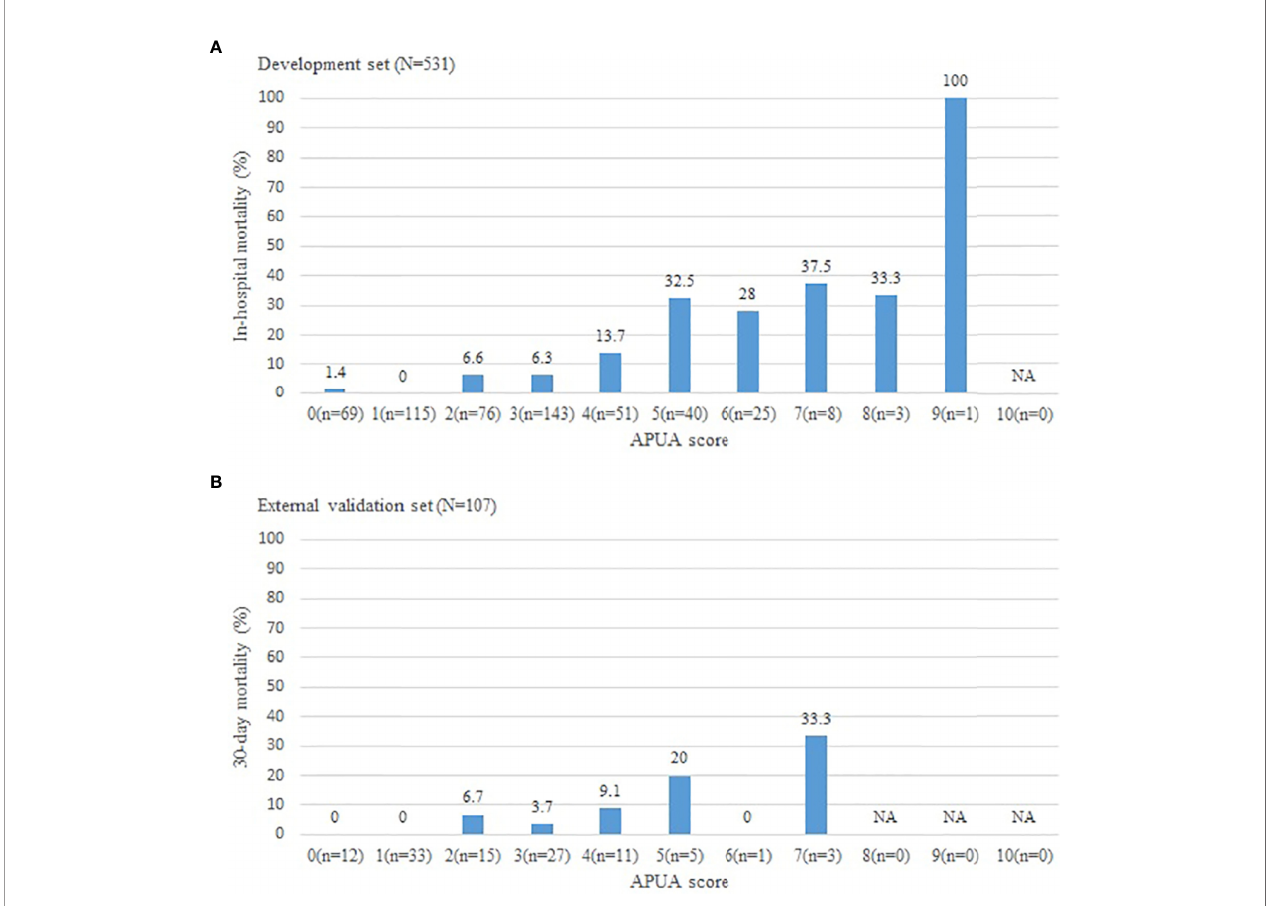
FIGURE 1 | The short-term outcome in community acquired pneumonia patients with different APUA score. (A) : Development set; (B) : External validation set. APUA score: Age, Pulse, Urea, and Albumin (APUA) score. NA, Not